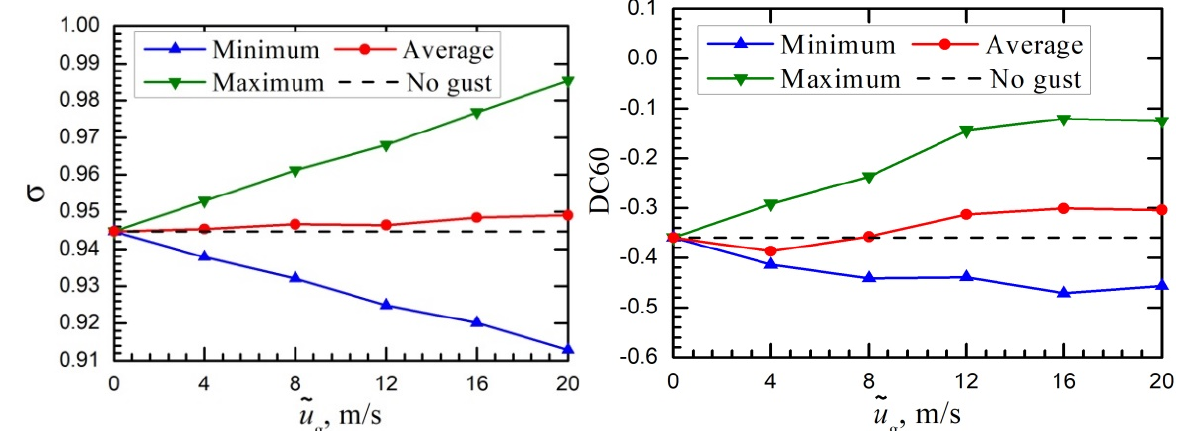
Figure 27. The inlet performance responses to the gusts with various amplitudes at a frequency of f = 50 Hz. The results of the no-gust case are also presented for comparison purpose. The results of both parameters are presented in Figure 28. Both the total pressure recovery and distortion amplitudes experience an ascending, descending, and re-ascending process as gust frequency increases, with the maximum at f D/ u 0 = 0.102 and 0.081(i.e, f = 125 Hz and 100 Hz, respectively). On the other hand, the total pressure recovery amplitude increases linearly with the increasing gust amplitude over the full range, while the distortion amplitude increases monotonously till (cid:101) u g / u 0 = 0.2 (i.e, (cid:101) u g = 16 m/s) and drops beyond that. These results indicate that the dependence of the inlet performance response on the gust frequency is much more complicated than that on the gust amplitude.